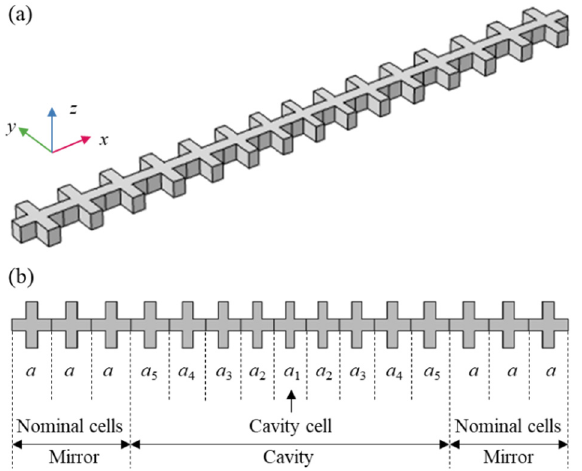
Figure 1. The mechanical nanoresonator. ( a ) The 3D schematic diagram; ( b ) the view of the x-y